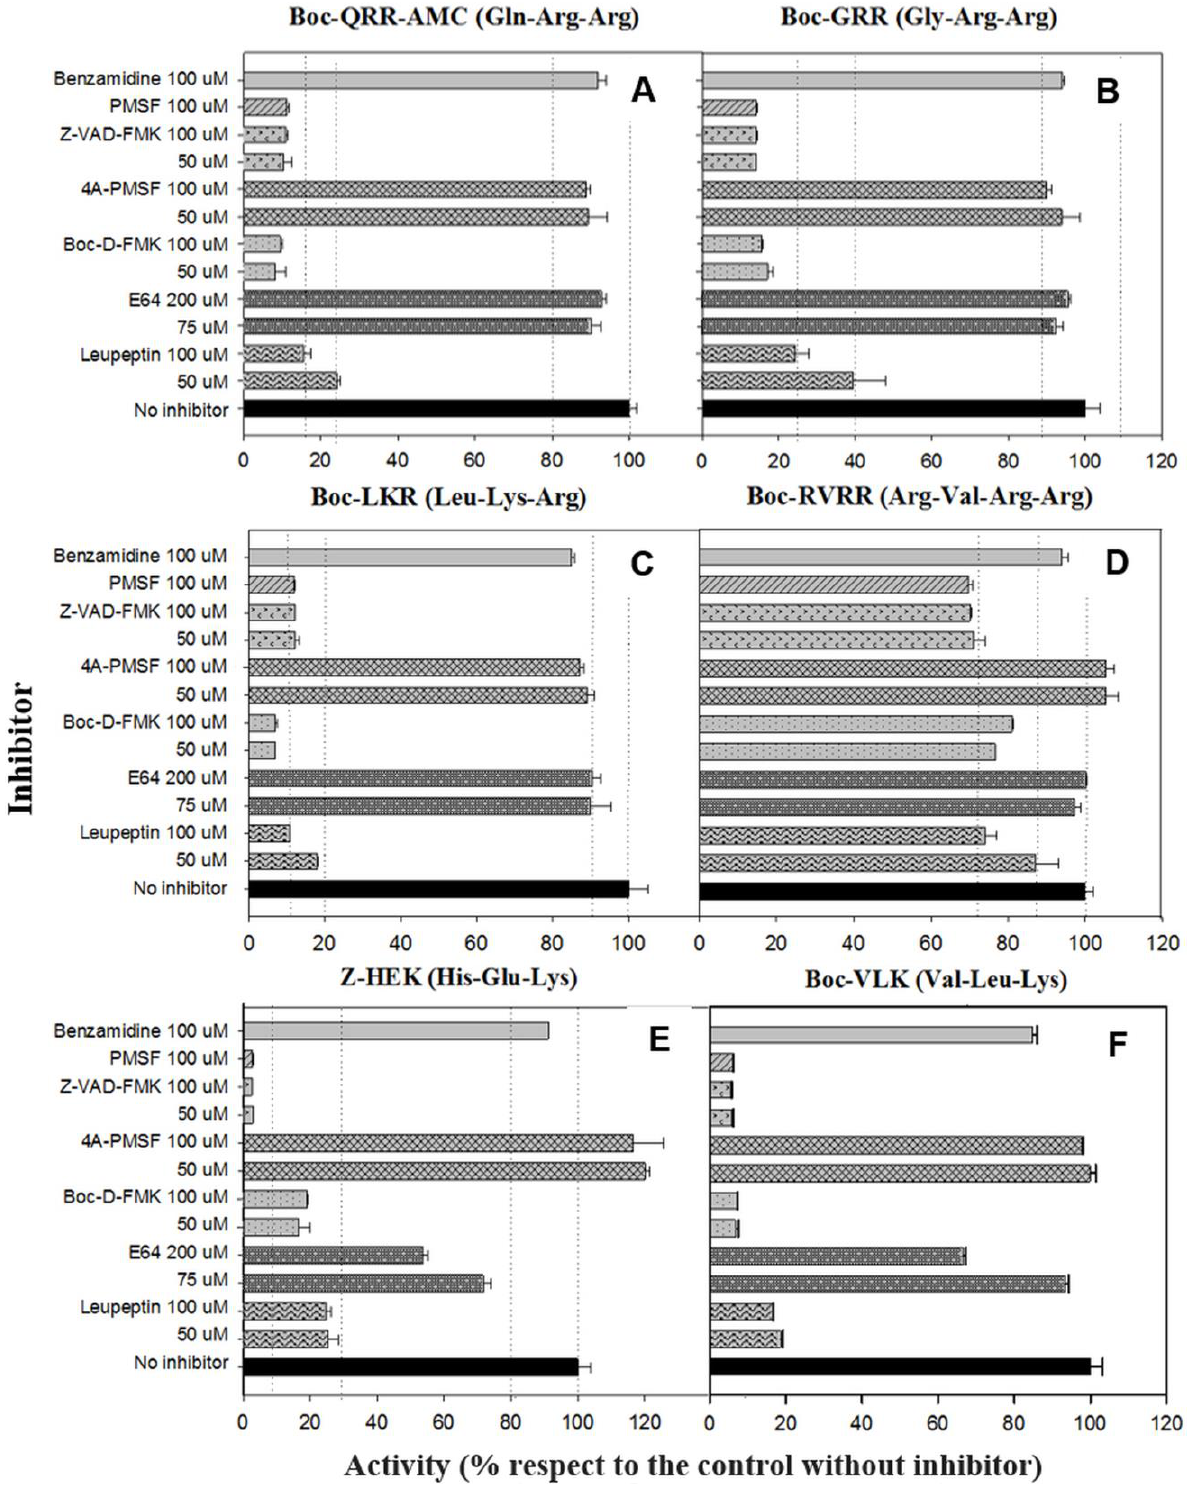
OPEN ACCESS | www.microbialcell.com